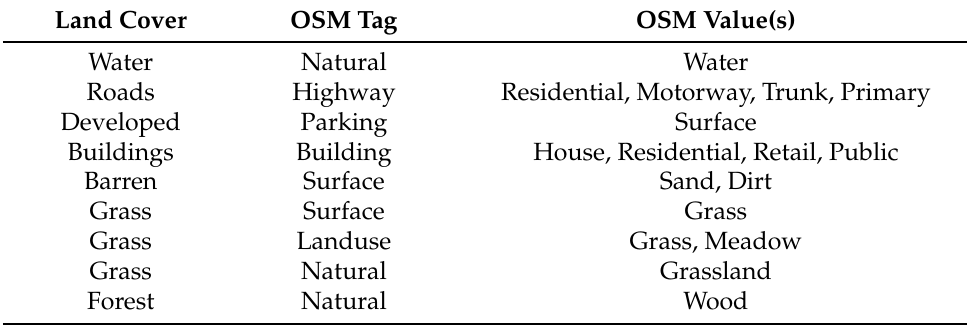
Table 2. OpenStreetMap keys and tags used to train land class classification